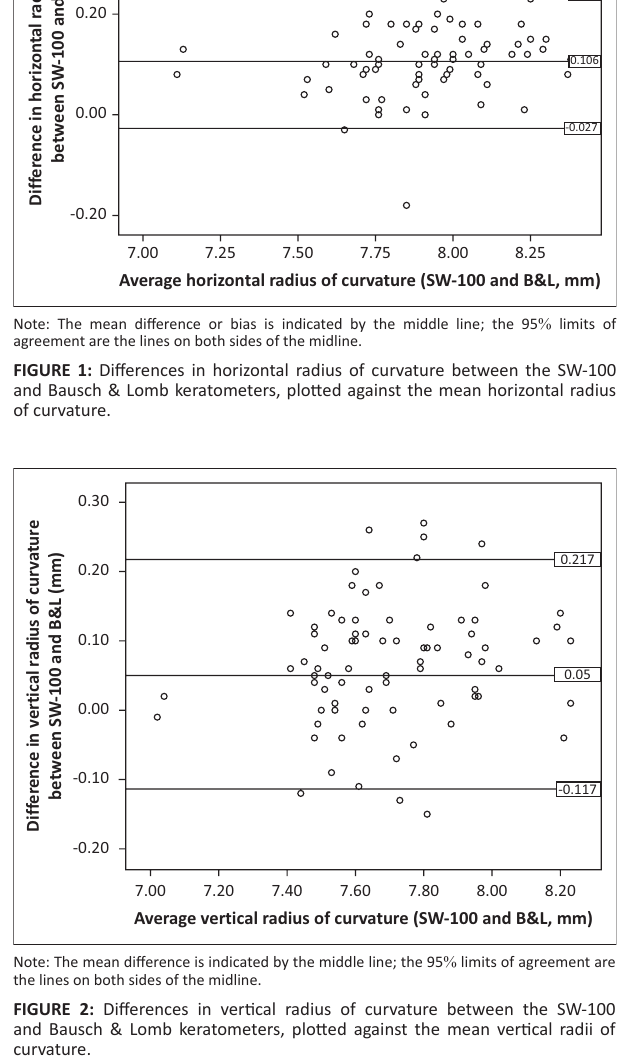
and B&L devices for the average radii of curvature are given in Figure 3. The LoAs between the two methods (SW-100 and B&L keratometers) were - 0.03–0.24 (or ± 0.14 mm) for the horizontal meridian and - 0.12–0.22 (or ± 0.17 mm) for the vertical meridian. In addition, the LoA between methods was - 0.09–0.23 (or ± 0.16 mm) for the average radius of curvature. The means and standard deviations of the two repeated measurements of the curvature of the horizontal and vertical meridians obtained with each instrument in each subject in one session are shown in Table 2. For the inter-test study, the range of 95 % LoAs are ± 0.74 mm (1.48 mm) for the vertical radius of curvature, and ± 0.76 mm (1.52 mm) for the horizontal curvature between the first and